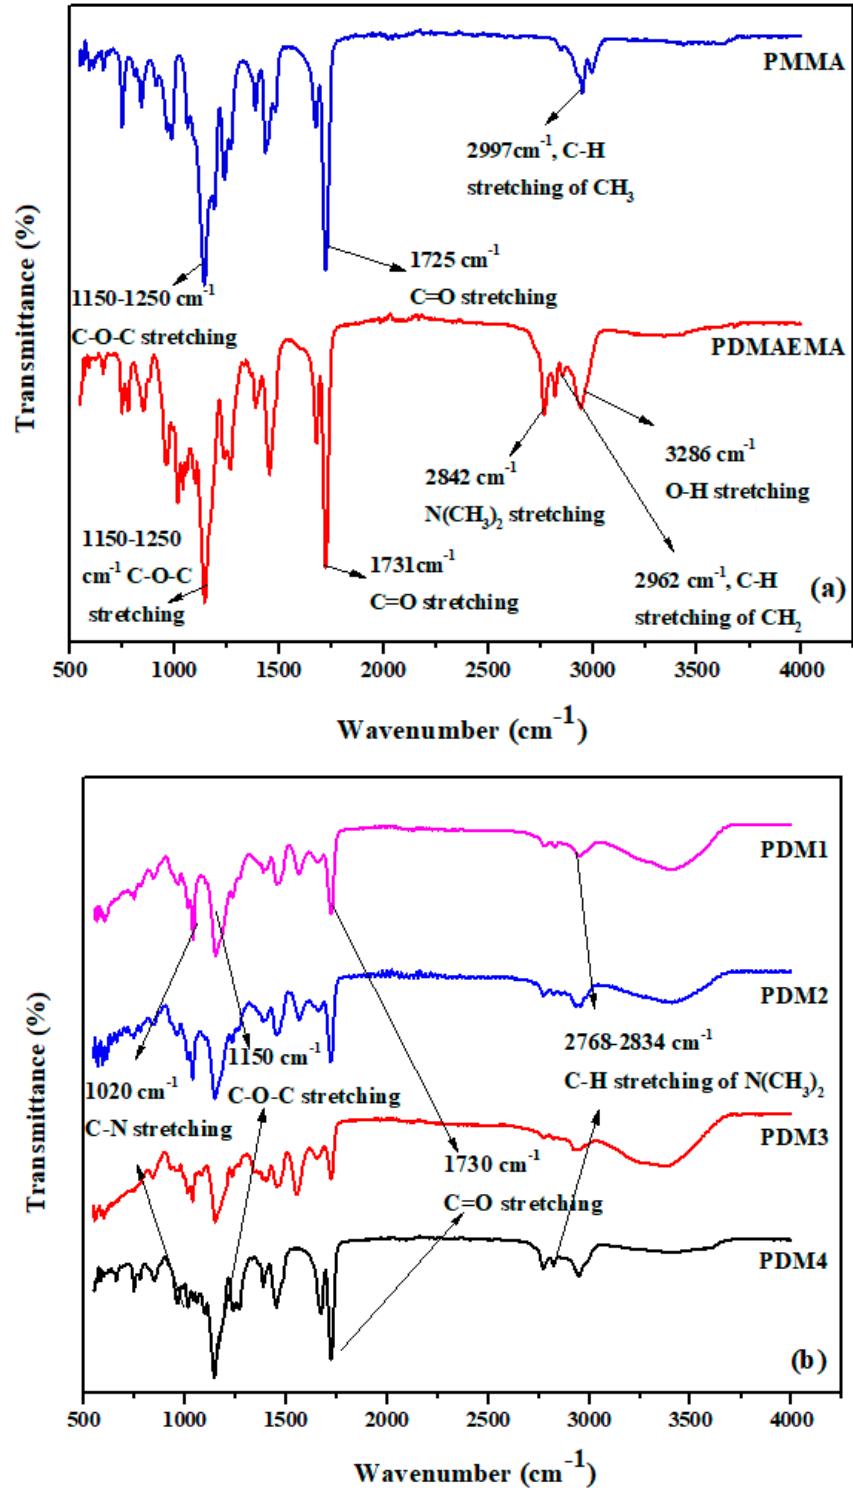
Figure 4. FTIR spectra of: ( a ) Homopolymers PDMAEMA and PMMA; ( b ) Copolymers of P(DMAEMA-co-MMA) PDM1, PDM2, PDM3 and PDM4.